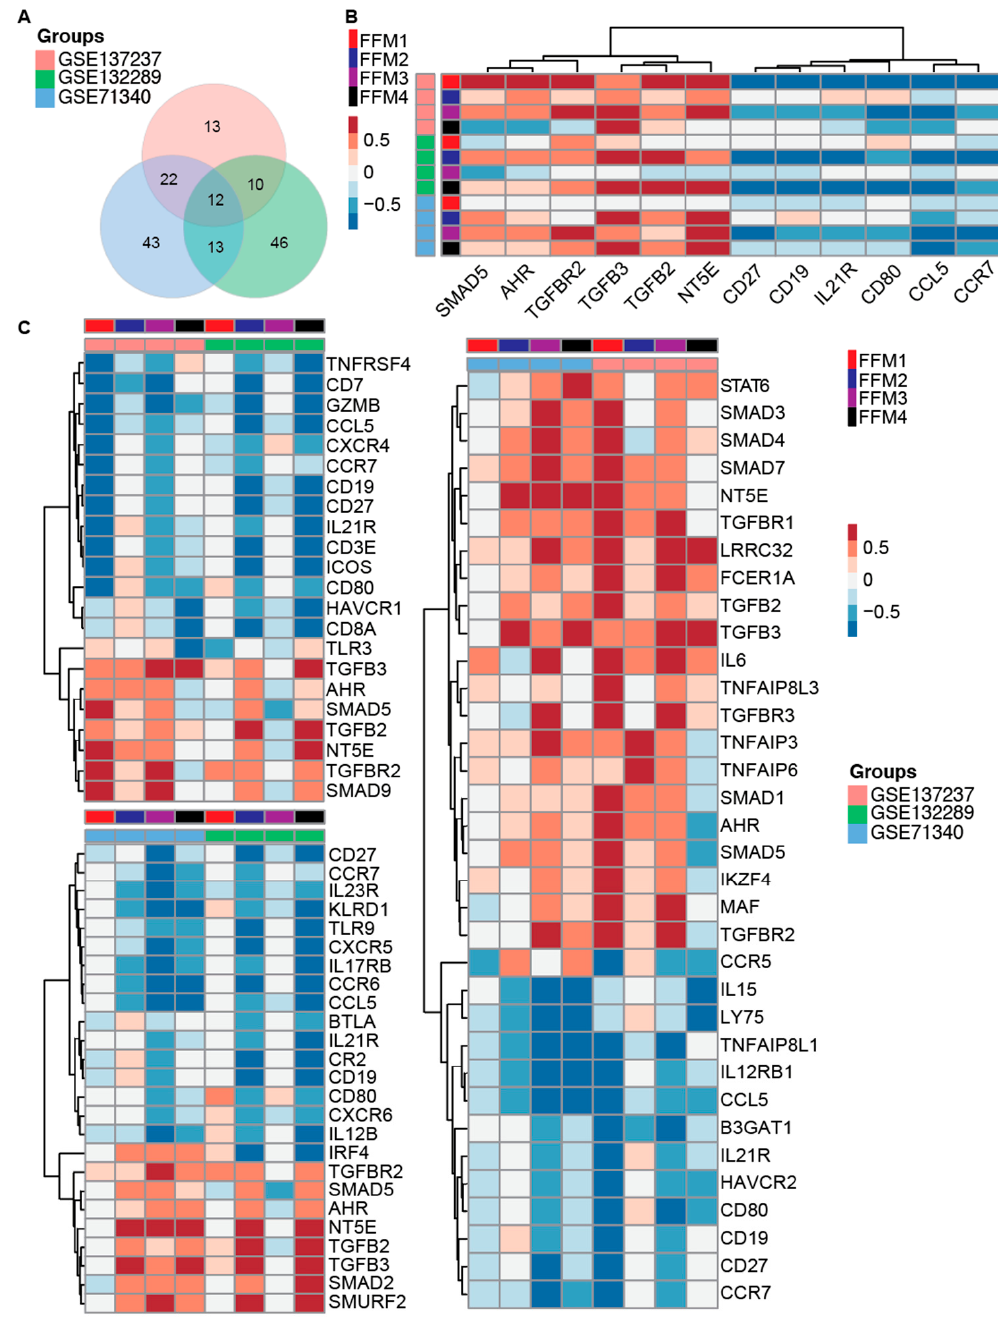
Figure 5. Immuno-markers that overlap between the primary tumors vs. metastasis (GSE137237), mouse omentum vs. omental metastasis (GSE132289) and human omentum vs. omental metastasis (GSE71340). ( A ) Venn diagram depicting the number of overlapping immune markers in GSE71340, GSE132289 and GSE137237 datasets. ( B ) Heatmap showing the Spearman correlation of 4 fibroblast functional modules and 12 immune-associated markers common to all 3 datasets in metastatic tissues. ( C ) Left top, heatmap showing the Spearman correlation of 4 fibroblast functional modules and 22 immune-associated markers that overlapped between GSE137237 and GSE132289. Left bottom, heatmap showing the Spearman correlation of 4 fibroblast functional modules and 25 immune-associated markers overlapped by GSE71340 and GSE132289 datasets. Right, heatmap showing the Spearman correlation of 4 fibroblast functional modules and 34 immune-associated markers overlapped by GSE71340 and GSE137237 datasets. Red or blue boxes in heatmap indicate positive or negative correlation between the immune-associated marker and the corresponding fibroblast functional module, respectively (FFM1–4).